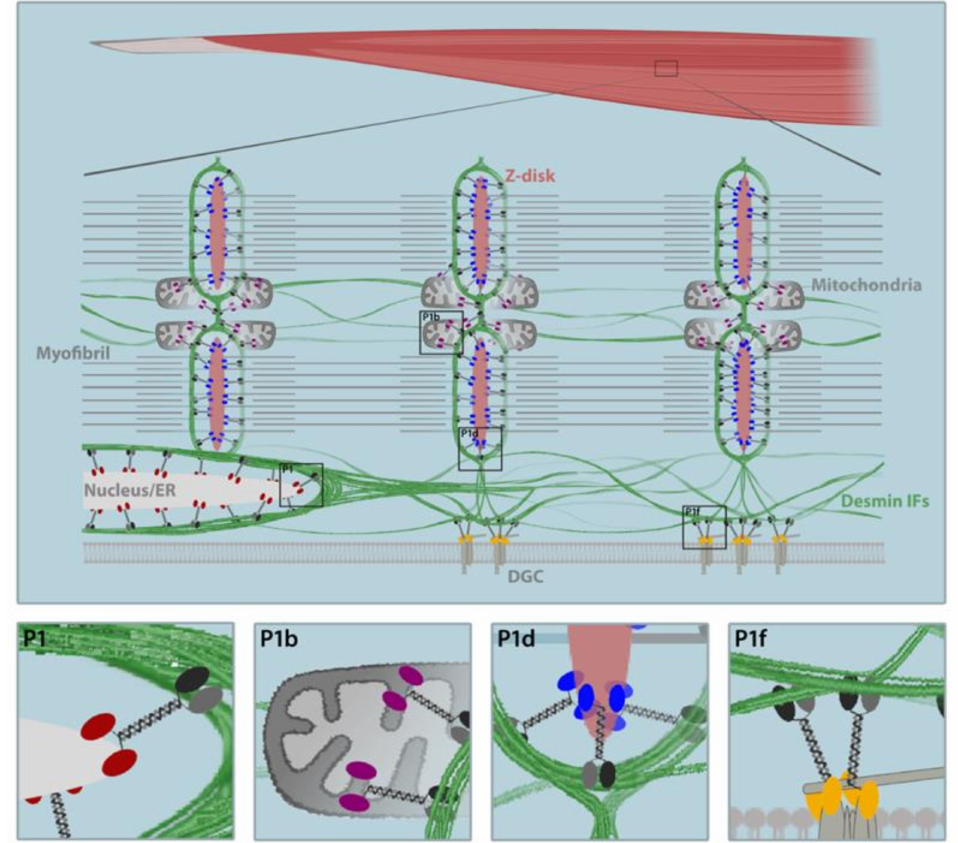
Figure 6. Scheme depicting plectin’s versatile function in skeletal muscle. Distinct localization and desmin IF-anchoring functions of plectin isoforms, determined by the differentially spliced N-terminal exons, are highlighted: plectin isoform 1 (P1, red) targets desmin IFs to the outer nu- clear/endoplasmic reticulum (ER) membrane system, P1b (purple) targets them to the mitochon- dria, P1d (blue) to the Z-disks, and P1f (yellow) targets them to the costameric lattice/dystrophin– glycoprotein complex (DGC). As such, by interlinking neighbouring myofibrils and cytoplasmic organelles with the sarcolemma, plectin provides stability to the extrasarcomeric